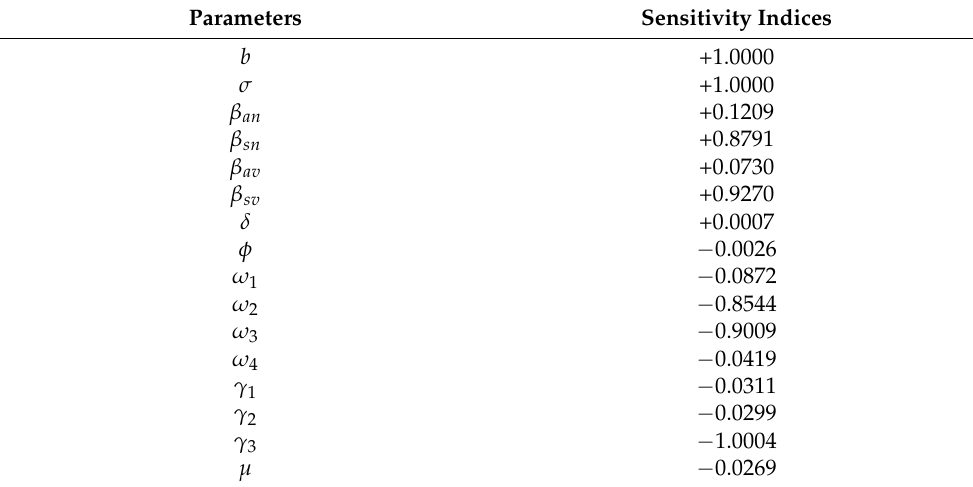
Table 3. Sensitivity values of the basic reproduction numbers.